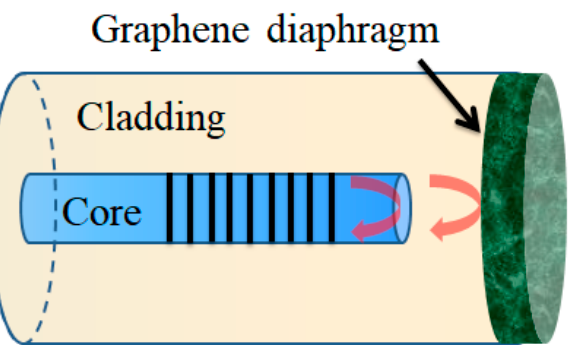
Figure 12. FBG sensor integrated with graphene for simultaneous detection of temperature and pressure.